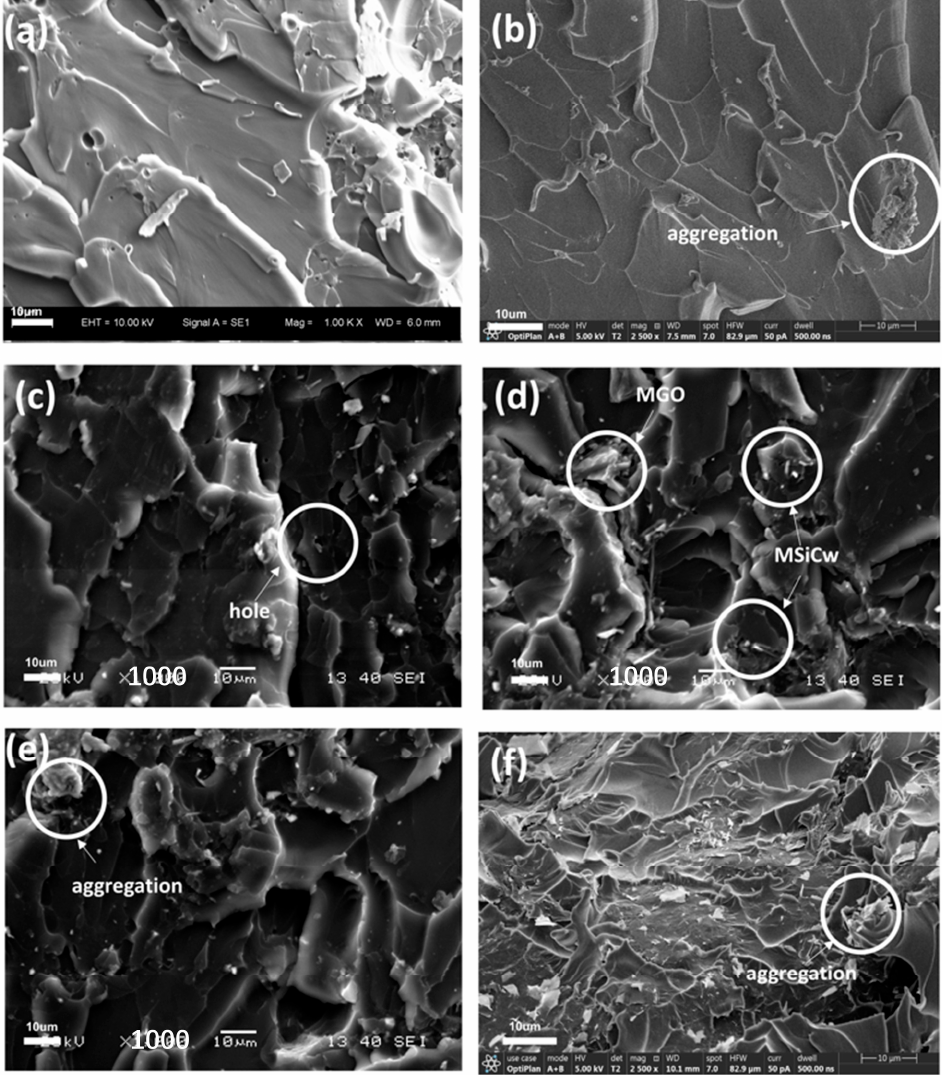
Figure 4. SEM images of tensile fracture surfaces of PI ( a ), SiCw-1-PI ( b ), MSiCw-1-MGO-0.2-PI ( c ), MSiCw-1-MGO-0.3-PI ( d ), MSiCw-1-MGO-0.5-PI ( e ), GO-0.3-PI ( f ).